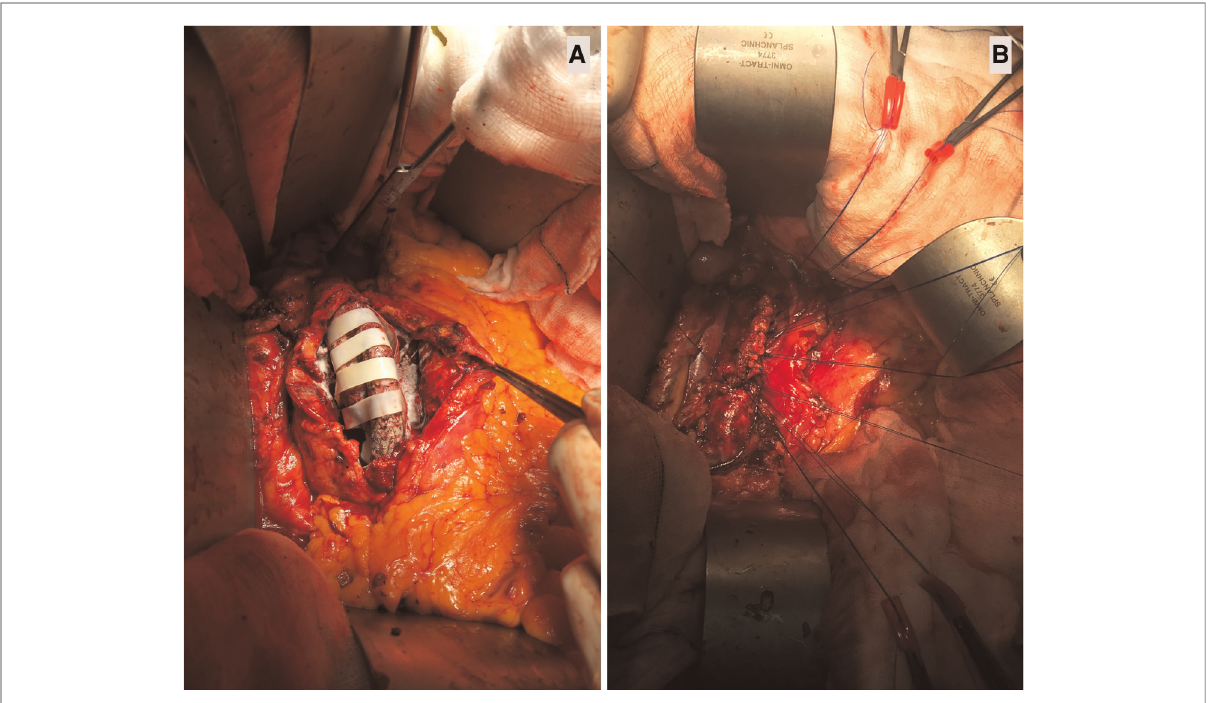
FIGURE 3 Aortic sacotomy with obliterating endo-aneurysmorrhaphy and stent-graft preservation post-EVAR. (A): Wrapping the opened aortic sac with XenoSure biological patch (LeMaitre Vascular, Inc., MA, USA) during double breasting. This 82-year-old patient had endovascular aneurysm repair (EVAR) with polytetra fl uoroethylene (PTFE) GORE graft (GORE®, Flagstaff, Arizona, USA) in 2008, after which the aortic sac shrunk to 4.2 cm. However, the patient had tissue plasminogen activator (TPA) twice for acute MI in 2018, resulting in aortic sac hygroma with sac expansion